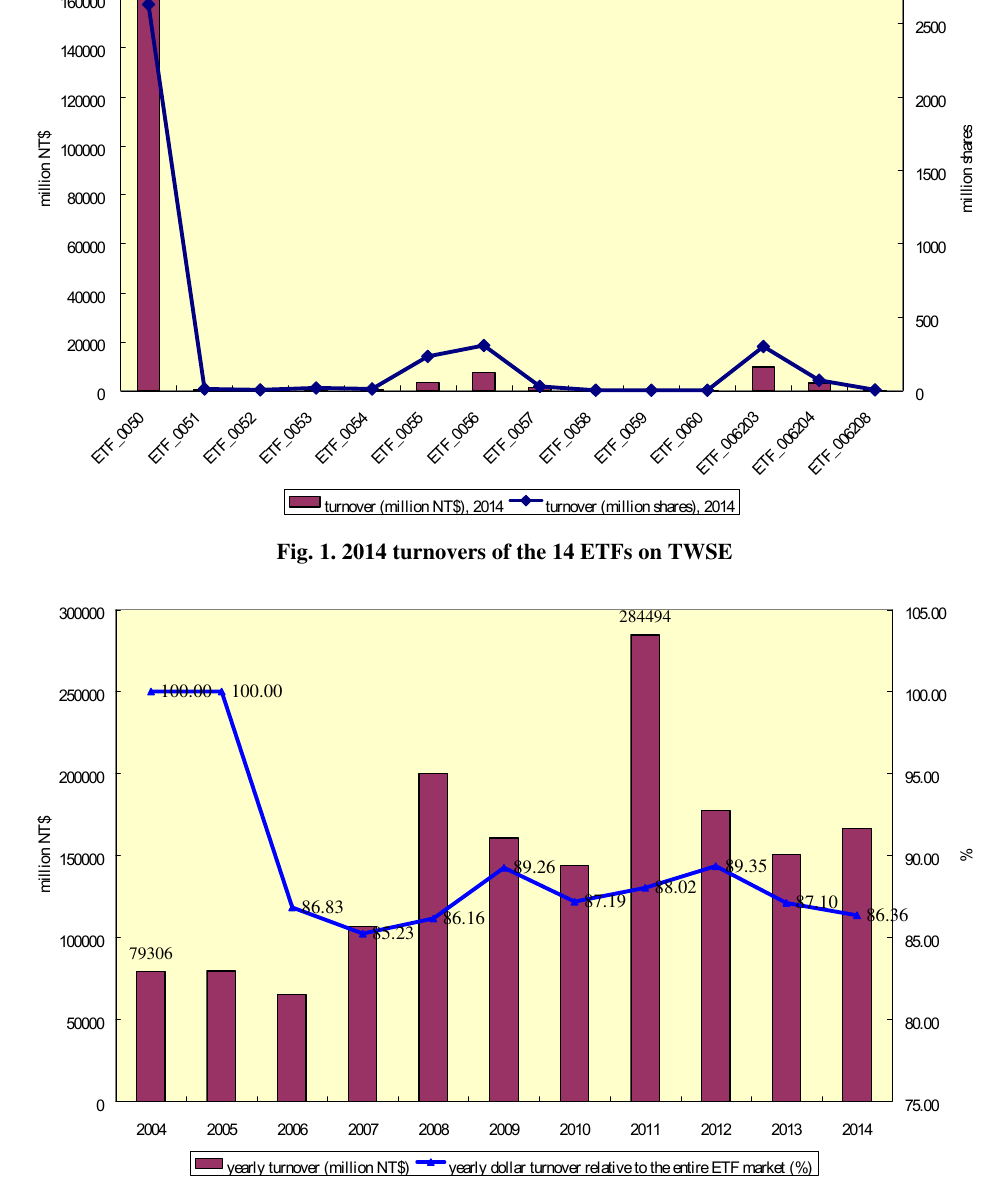
Fig. 2. Yearly turnovers of the Taiwan 50 ETF, absolute numbers and relative to the entire ETF market, 2004 to